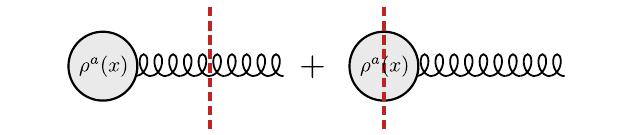
Fig. 1 Physical interpretation of the Lipatov vertex, with the vertical dashed line denoting the interaction with the target